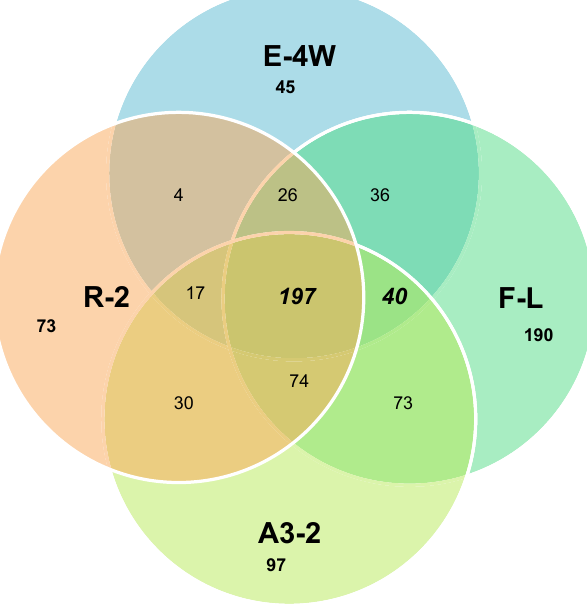
Figure 5. Venn diagrams representing the number of OTUs shared between the different